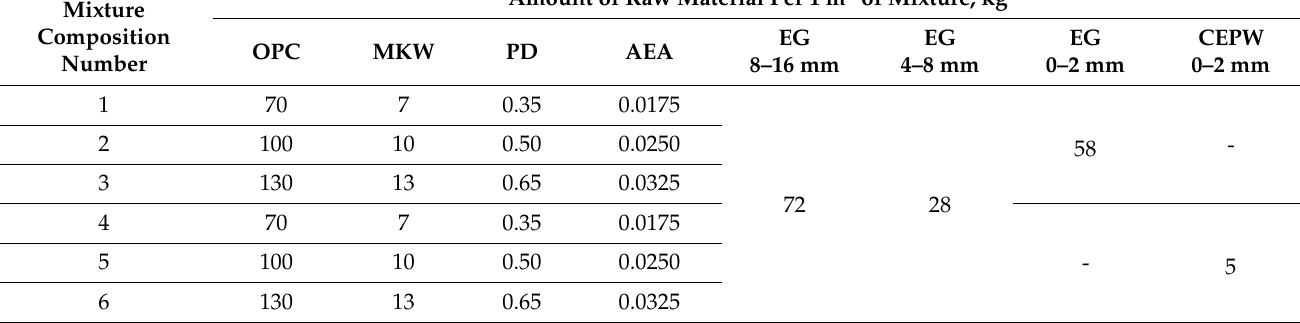
Table 6. Compositions of mixtures of LWAC